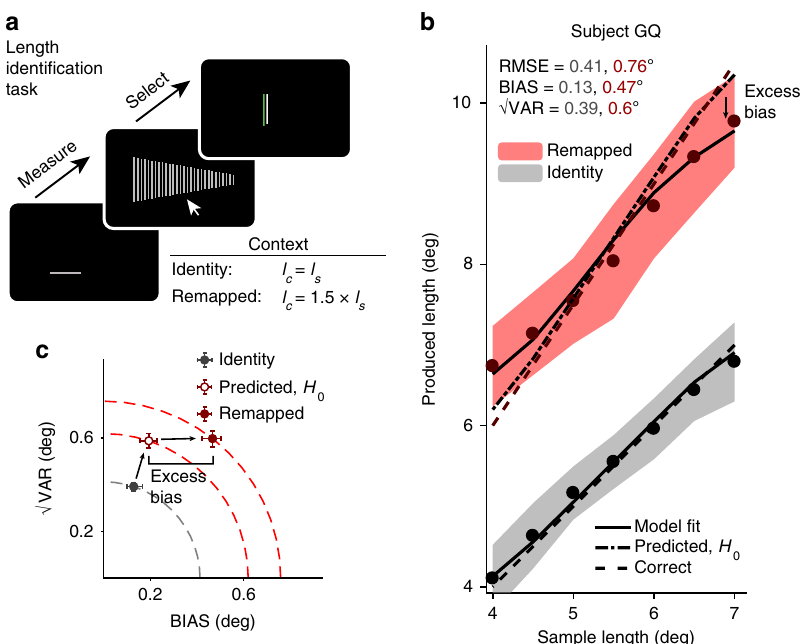
Fig. 8 Length measurement and identi fi cation task, gain = 1 and 1.5. a Trial structure. Subjects fi rst measured the sample length l s of a gray horizontal bar presented brie fl y. After the bar was extinguished, subjects used the mouse to select from several options the bar which was as close in length as possible to the correct length l c = gain × l s . In the identity context, gain = 1, whereas in the remapped context, gain = 1.5. There was no time limit to make a response. After the response, subjects were shown a white bar of the correct length, and the selected bar changed to either red or green depending on accuracy (see Methods). b Performance of an example subject in the identity (gray) and remapped (red) contexts (same format as Fig. 2). Similar to the sensorimotor tasks (Figs. 2b, 4b and 6b), the subject ’ s behavior showed excess bias beyond what was predicted assuming no additional MTN. Shaded regions show mean ± one standard deviation. c √ VAR vs. BIAS plot shown in the same format as Fig. 2c. RMSE and BIAS in the remapped context